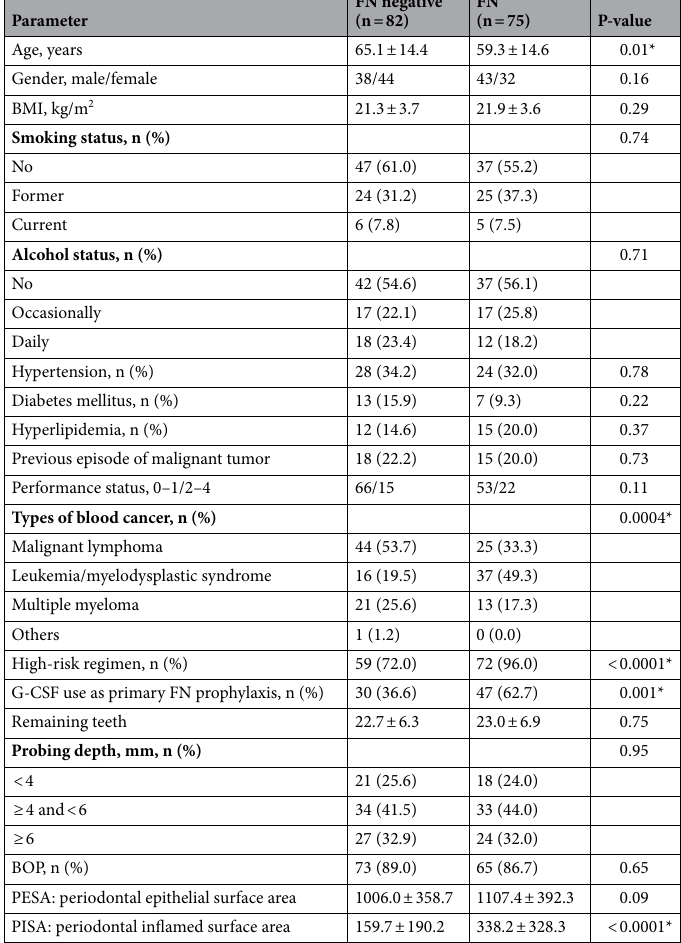
Table 2. Comparison of clinical characteristics between FN and FN negative groups. *P < 0.05 (statistically